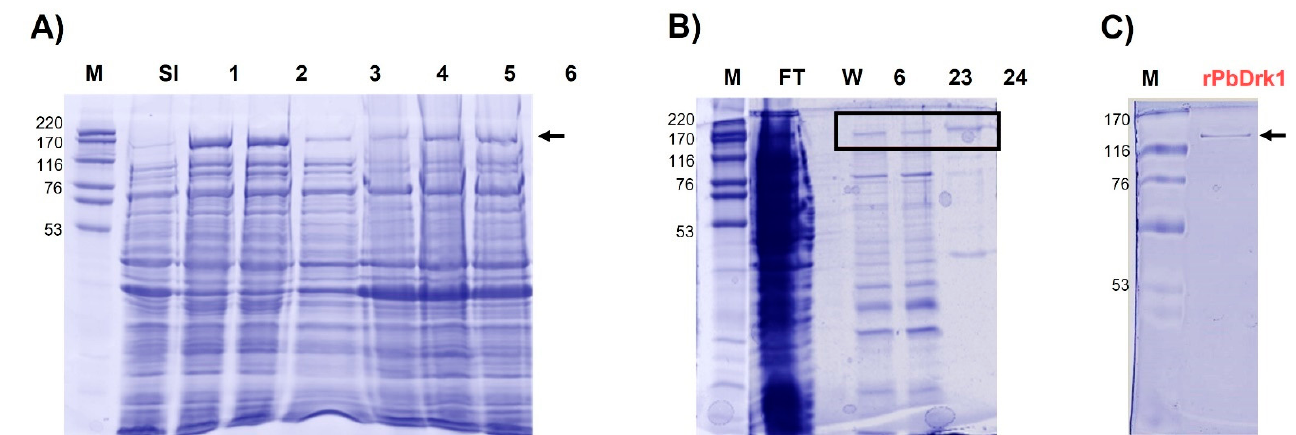
Figure 1. PbDrk1 expression and purification. ( A ) Expression of PbDrk1 in Escherichia coli Rosetta cells transformed with pET28/DRK1 . Absence of IPTG (Lane SI); lanes 1 to 3: upon IPTG induction after 1, 3, and 24 h at 37 °C. Lanes 4 to 6: upon IPTG induction after 1, 3, and 24 h at 30 °C. ( B ) Protein purification after ion metal affinity chromatography (IMAC). SDS-PAGE of fractions from flow through (FT), wash (W), and 6, 23, and 24 elution fractions. ( C ) rPbDrk1 purified after affinity chromatography and passing by Centricon (100 kDa). Protein bands were revealed with Coomassie Blue staining. Lane M: standard protein marker (GE Healthcare, Chicago, IL, USA 53–220 kDa).